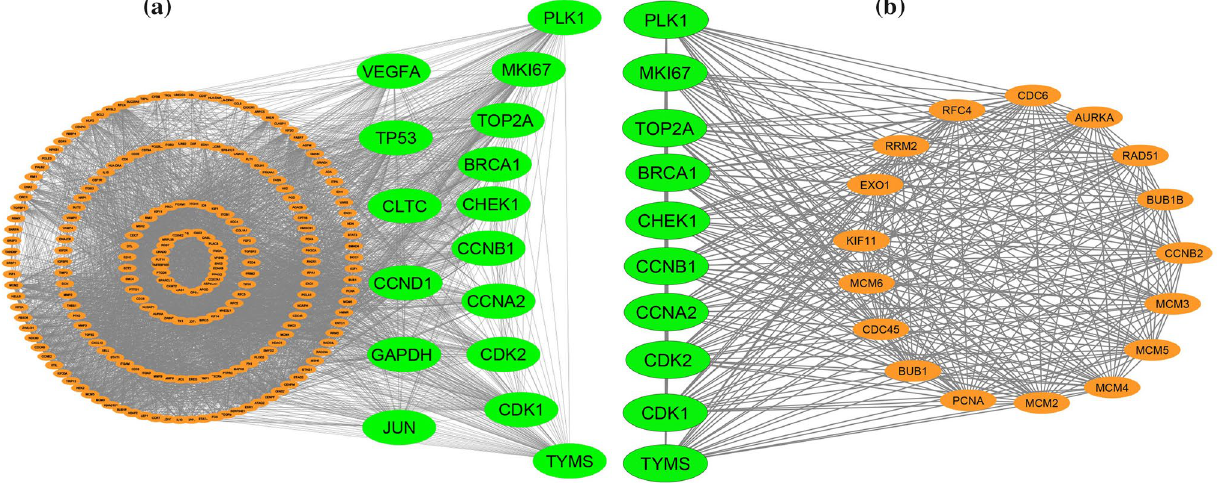
Fig. 2 a Protein-proteins interaction network for common differentially expressed genes of CC, and edges specify the interconnection in the middle of two genes. The analyzed network holds 229 nodes and 4488 edges. Surrounding nodes (PLK1, TP53, GAPDH, VEGFA, CDK2, MKI67, CHEK1, CDK1, BRCA1, TOP2A, CLTC, CCNA2, JUN, CCND1, CCNB1, TYMS) represented the hub genes. b Module analysis network obtained from MCODE analysis. Surrounding nodes (CDK2, CHEK1, MKI67, TOP2A, CDK1, BRCA1, PLK1, CCNA2, CCNB1, TYMS) were found to be com- mon across 10 hub genes, so we considered these ten genes as the key genes. The network represents highly interconnected regions of the PPIs network. The network holds 27 nodes and 350